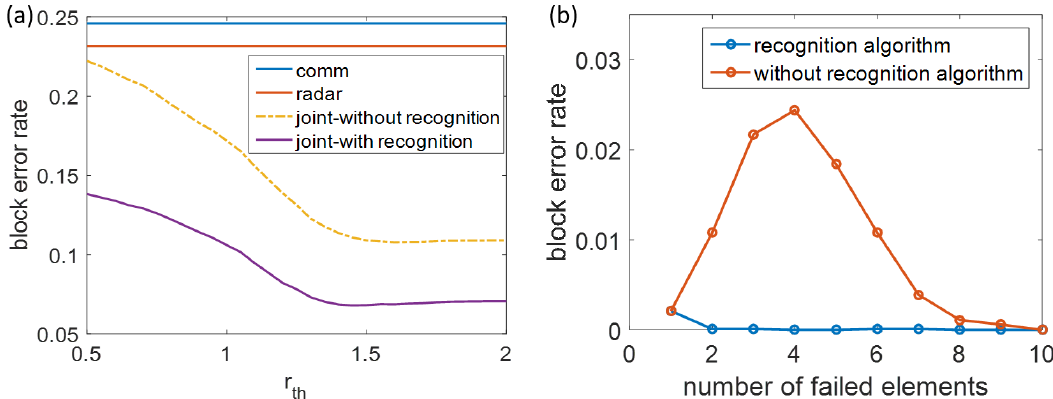
Figure 8. Analysis of the no-failure recognition: ( a ) block error rate of the joint diagnosis with and without no-failure recognition; and ( b ) the ratio of the no-failure sub-array misjudged as failed elements is significantly reduced with the no-failure recognition